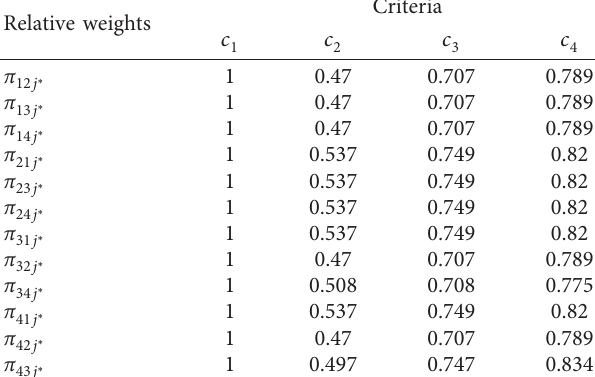
Table 3: Relative weights.